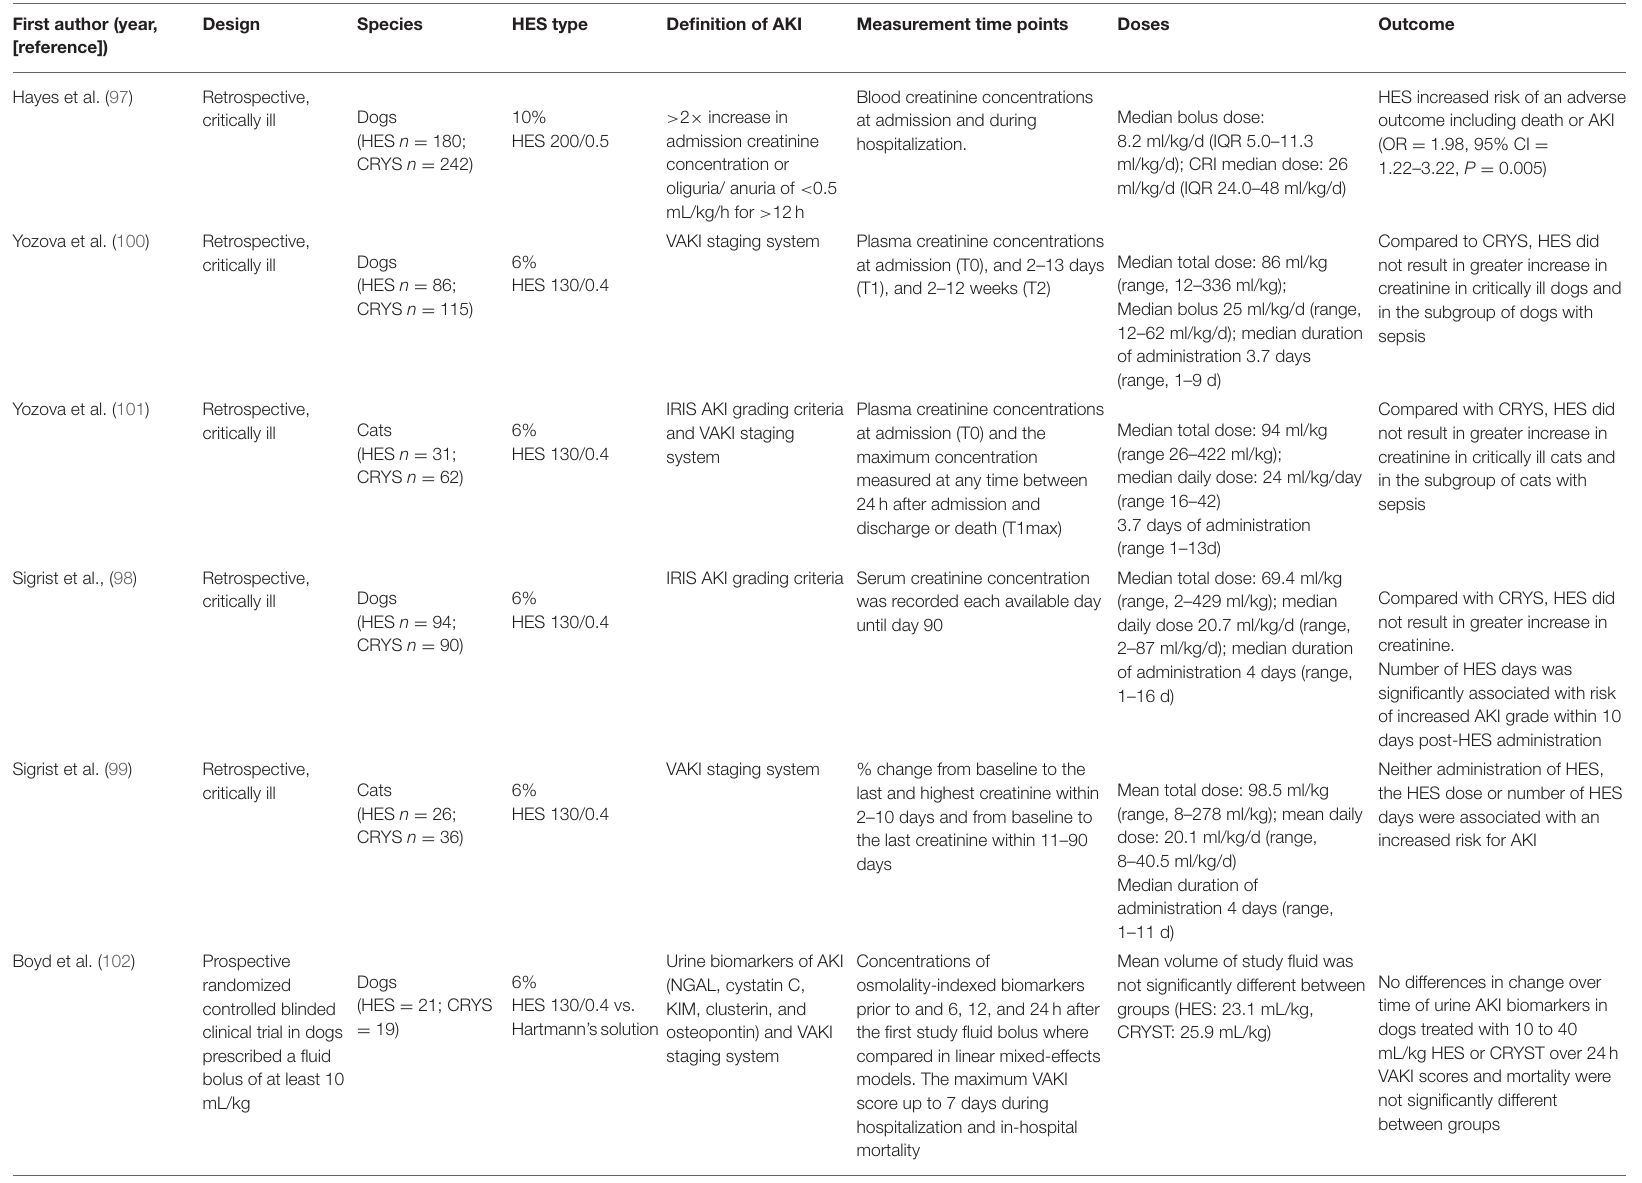
TABLE 2 | Clinical studies evaluating kidney injury after HES administration in dogs and cats (sorted by publication